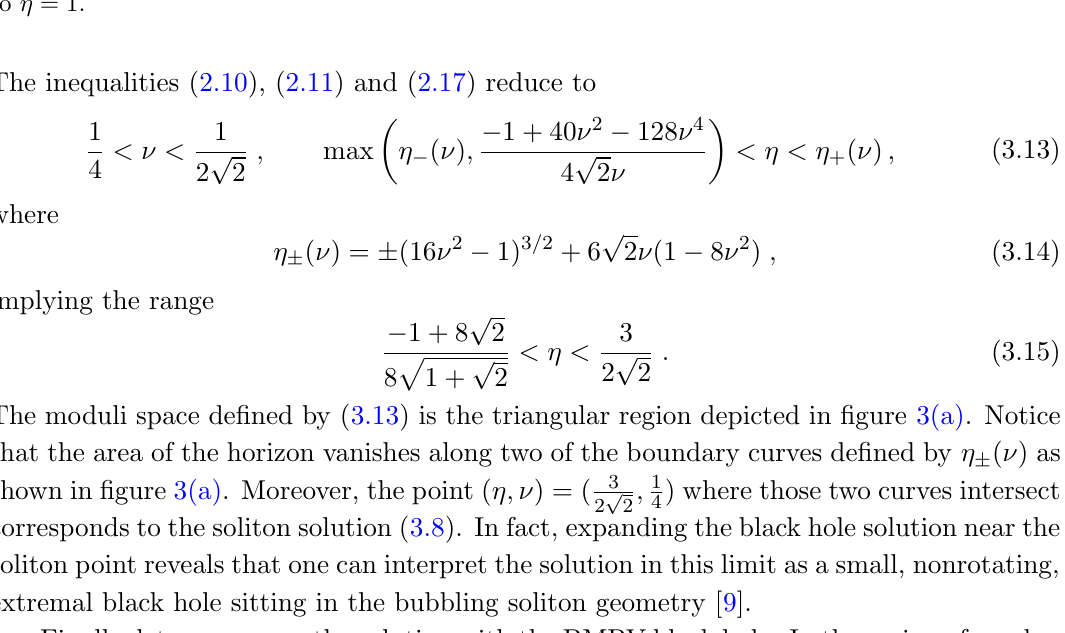
Figure 3. (a) Moduli space for the J (cid:30) = 0 spherical black hole I (0 < a 1 < a 2 , h 0 = 1, h 1 = (cid:0) 1, h 2 = 1). (b) Dimensionless area of the spherical black hole I (orange/lighter) and the BMPV black hole (blue/darker), in the region of overlap. Observe that a H > a BMPV in a narrow region close to (cid:17) =